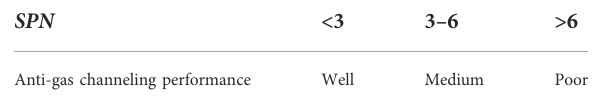
TABLE 4 Evaluation criteria for gas channeling prevention performance of SPN